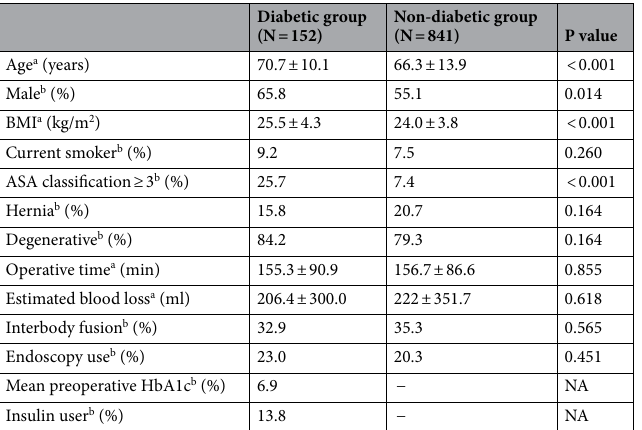
Table 1. Demographic and patient characteristics (N = 993). BMI, body mass index; ASA, American Society of Anesthesiologists. a The values are given as the mean and standard deviation. b The values are given as the percentage in each group.